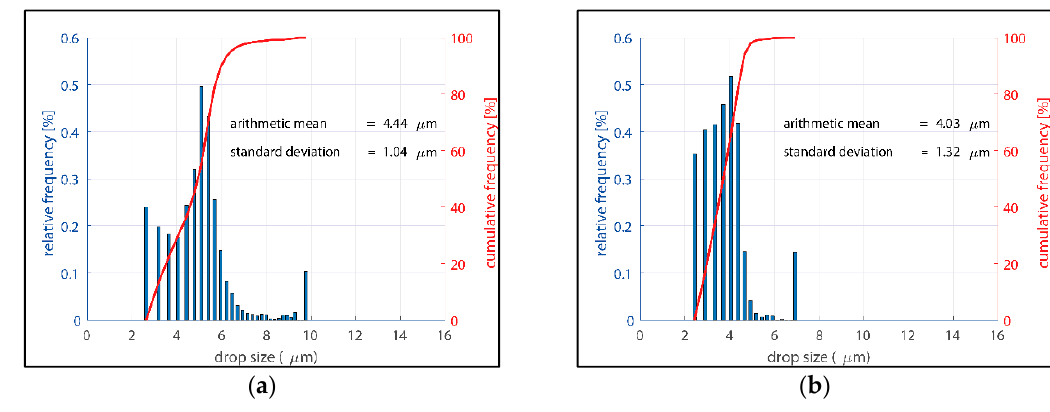
Figure 6. ( a ) drop size distribution of the laboratory emulsion 30 kg/h; ( b ) drop size distribution of laboratory emulsion 60 kg/h.